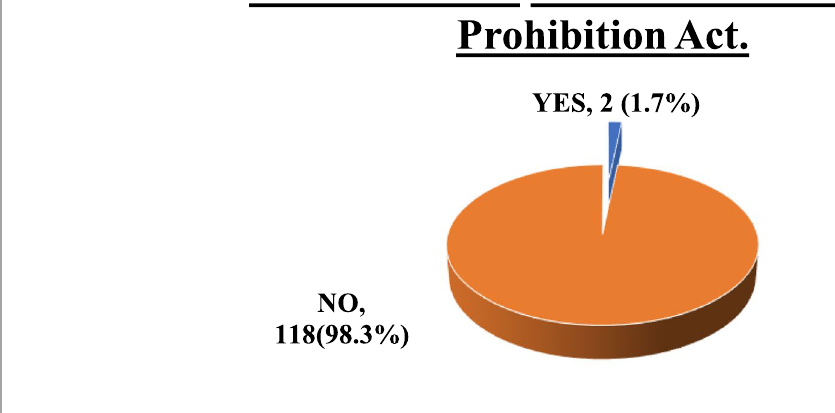
Fig. 6 Distribution of cases under the Dowry Prohibition Act